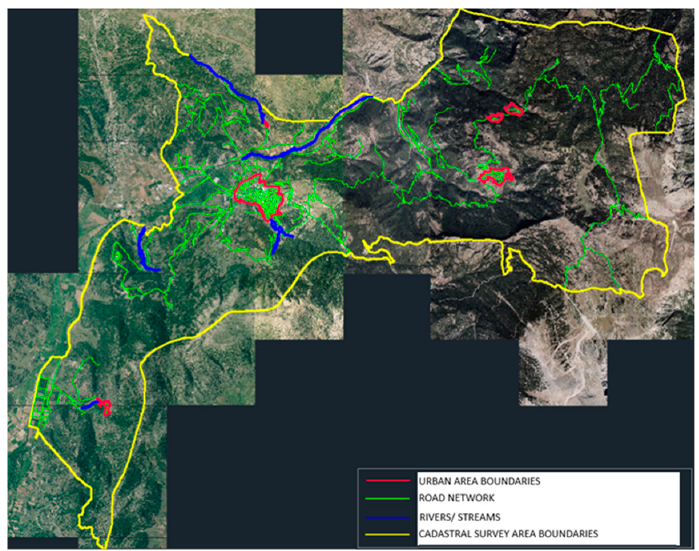
Figure 10. Urban area boundaries, road and river networks in the area under cadastral survey. Source: [35].